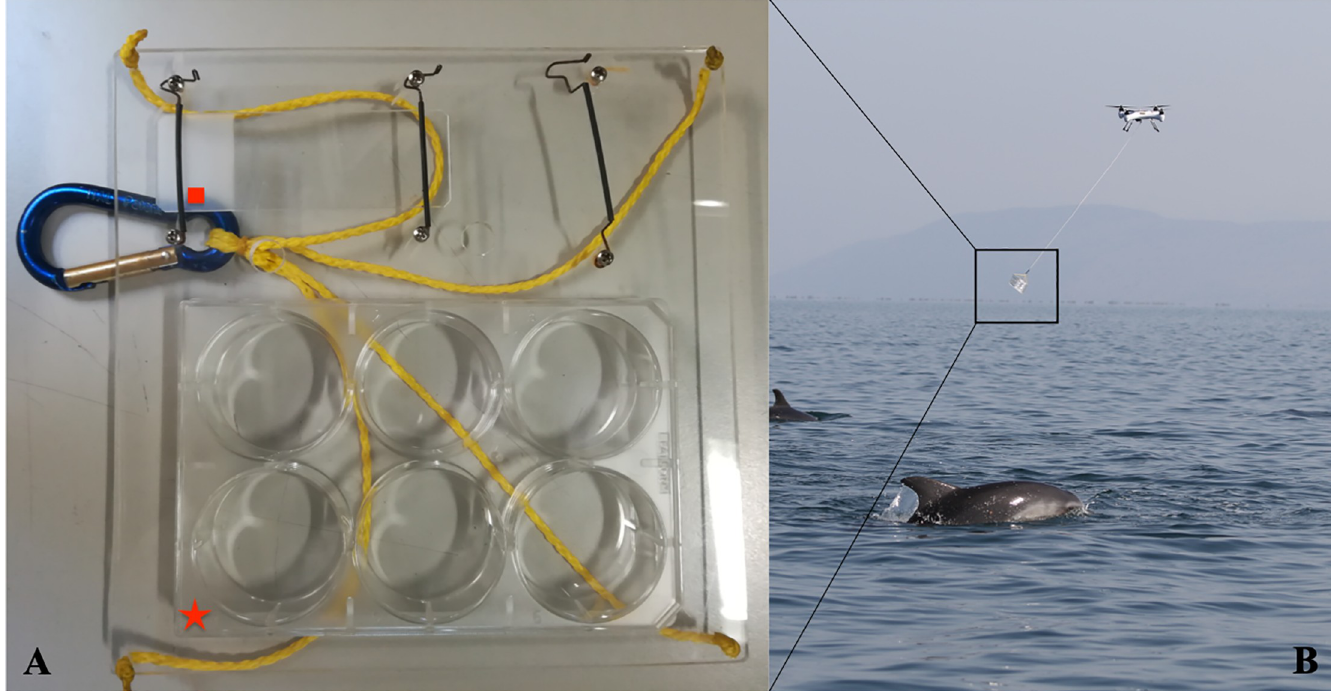
Fig 1. Sampling tool. (A) The tool composed by a 6-well polystyrene sterile Petri plate (Falcon TM ), marked with a red star, and a cytology glass, marked with a red square, mounted on a Plexiglas support. (B) The unmanned quadcopter drone (SplashDrone, Swellpro Technology Co., Ltd) is used to collect blow samples via the sampling tool suspended at 2 m from the drone